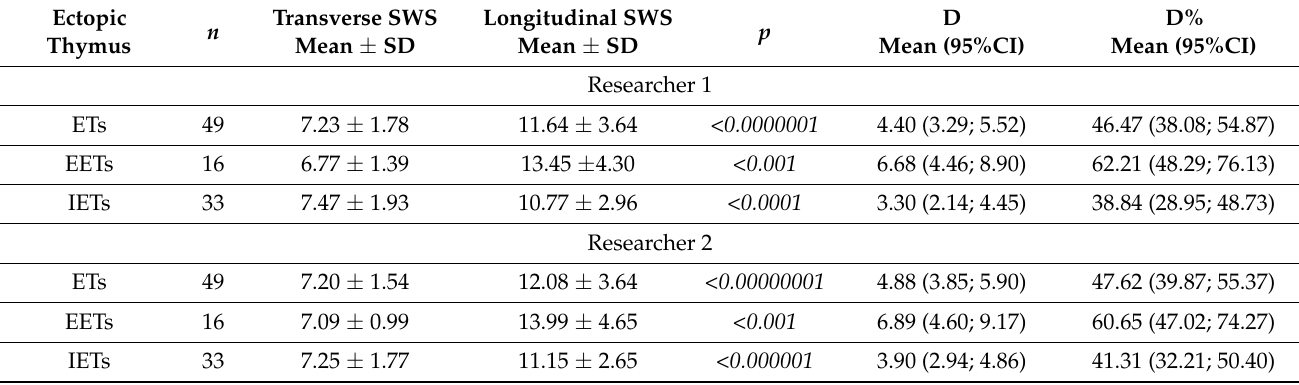
Table 2. Comparison of SWS values of ectopic thymuses measured in the transverse and longitudinal planes.